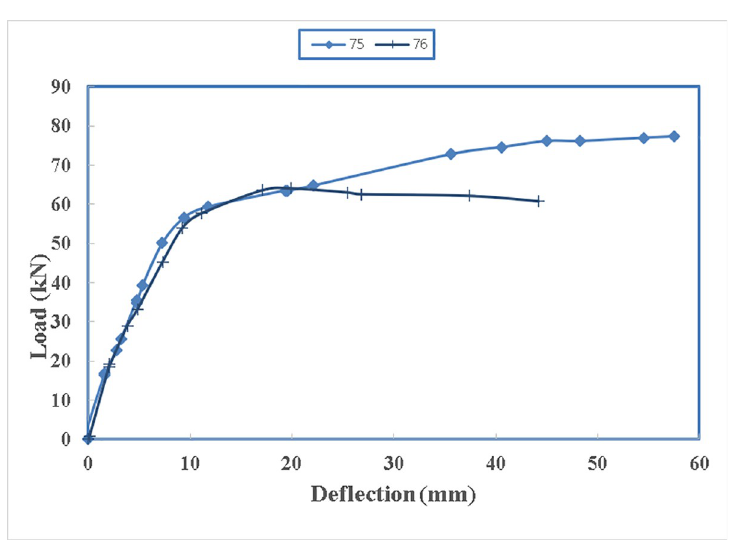
Fig 31. Load- deflection diagram between beam 75 and beam